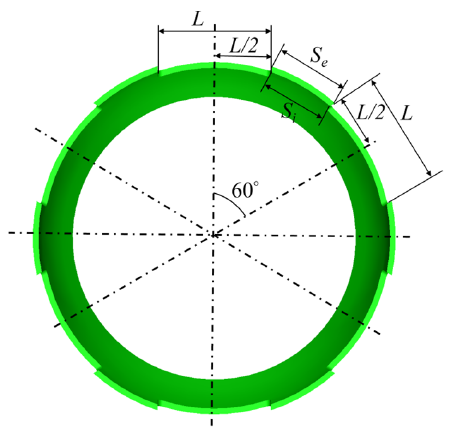
Figure 8. The cross-section of ball cage passing through the center of the sphere. According to Equations (15) and (16), the outer spherical diameter ( D e ) and the inner spherical diameter ( D i ) of the cage can be obtained. Then, the width of the outer spherical beam and the inner spherical beam can be solved as